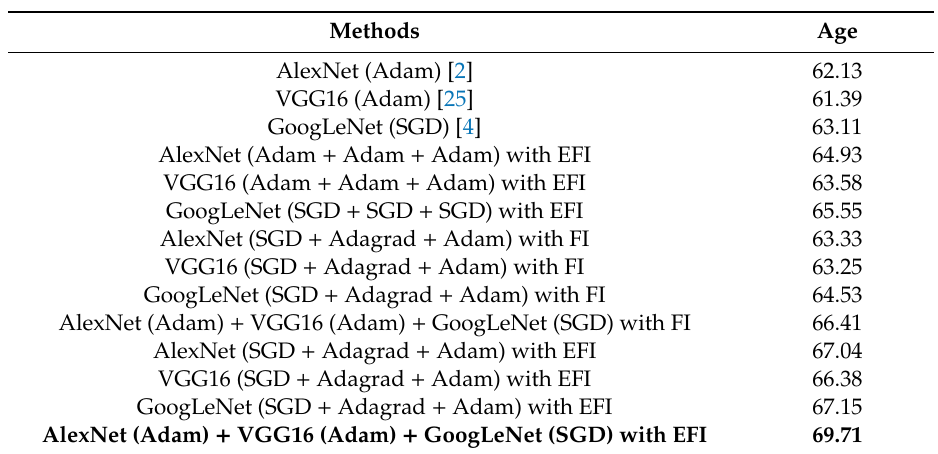
Table 13. Classification results of the CACD2000 database by the different methods.